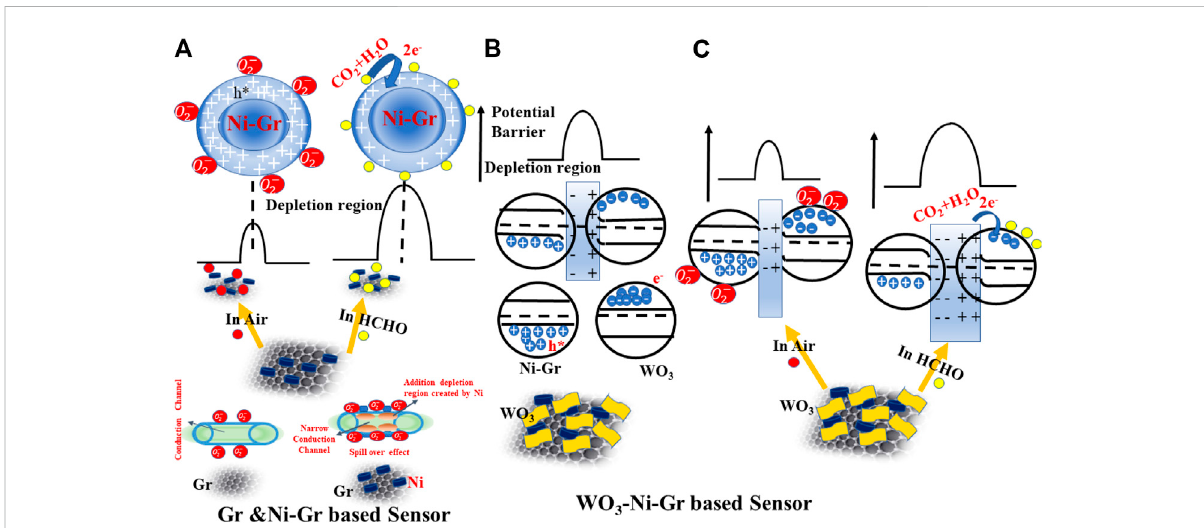
FIGURE 8 Schematicdiagram for thepassiblesensing mechanism of (A) Ni-Gr based sensor. Ni-Gr compositesexhibit thep-typebehavior. Inair-ionized chemisorbed oxygen species, due to the capture of electrons will increase the hole concentration (small resistance), while on HCHO exposure, the captured electrons are released back to the Ni-Gr composite and will decrease the hole concentrations (high resistance). (B) A possible mechanism of the WO 3 -Ni-Gr heterojunction formation between WO 3 and Ni-Gr. Electrons from WO 3 migrate to Ni-Gr to form the depletion region and heterojunction. (C) Schematic of a possible sensing mechanism of the WO 3 -Ni-Gr heterojunction on air and HCHO